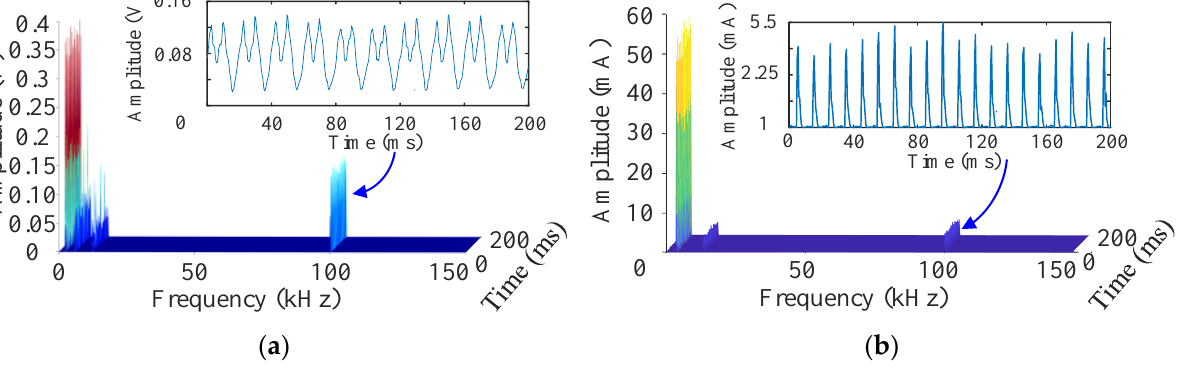
Figure 10. ( a ) LED voltage time and frequency diagram; ( b ) LED current time frequency diagram.